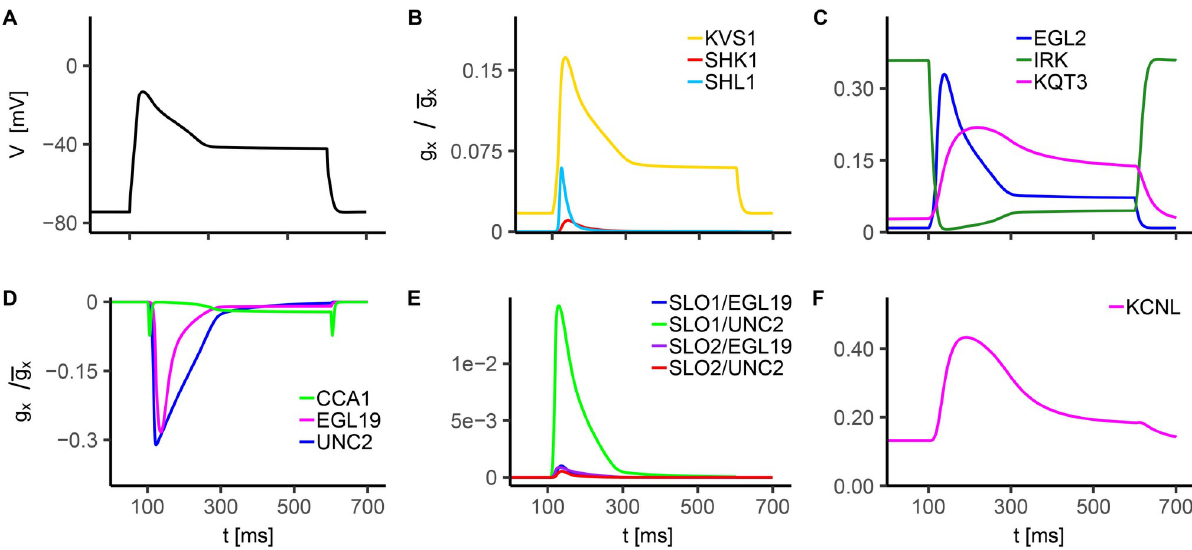
Fig 5. In silico analysis of AWC ON voltage response to current injection. The stimulation protocol consists in one single 15 pA current step with a duration of 500 ms. The holding current is I h = 0pA. A) WT Voltage response to 15 pA current injection. B-F) Normalized conductance for modeled currents . In these panels we report the time evolution of the normalized conductance of each modeled current for the WT current clamp simulation shown in panel A. The normalized conductance is defined as the product of the activation and inactivation variables of the considered ion current (e.g. for SHL1 g = � g ¼ m 3 ð 0 : 7 h f þ 0 : 3 h s Þ ). Panels B and C show g = � g for voltage-gated K + currents, panel D for voltage-gated Ca 2+ x x x x SHL1 SHL1 SHL1 currents, and panels E and F for calcium-dependent K + currents. The g = � g values for CCA1, UNC2 and EGL19 currents are multiplied by -1 to x x reproduce the sign of the associated currents.